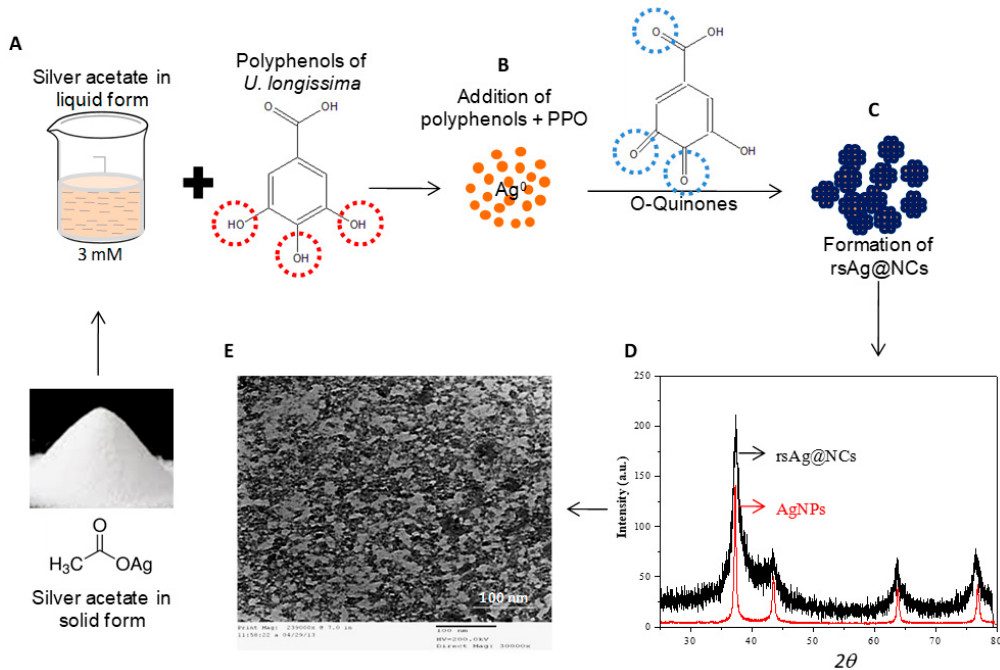
Figure 1. Approach to for fabricating bionanoclusters of silver (rsAg@NCs) using phytochemicals of Usnea longissima . ( A ) A solution of silver acetate (3 mM) was challenged with aqueous extract of U. longissima (AEU; 2 mg/mL) in reaction glassware. ( B ), Polyphenols of AEU reduce Ag + into Ag°, and form o -quinones, due to bioconversion of polyphenols by the action of polyphenol oxidase (PPO; 5 units/mL). Quinones contain an oxygen group (neutral charge), and an accumulation of quinones on the surface of AgNPs helps to form ( C ), clusters of AgNPs (denoted as “rsAg@NCs) due to the absence of electronic hindrances between the nanoparticle (NPs). ( D ) x-ray diffraction (XRD) pattern of the rsAg@NCs and AgNPs were recorded in the range of 20° to 80° at a 2 θ angle. XRD pattern of the rsAg@NCs depicts the well-resolved diffraction peaks broadening of the crystalline zerovalent silver (Ag°) NCs as compared to the AgNPs, which can be assigned to the reflection planes: 111, 200, 220, and 311. ( E ) Transmission electron microscopy(TEM) image reveals the shape, size, and clustering nature of the NCs. Red circles show the hydroxyl groups of the polyphenols, which are responsible for reducing the potential by donating hydrogen to Ag + and forming Ag°. Blue circles are indicating neutral charge-free oxygen molecules ( O -quinones) by the action of polyphenol oxidase (PPO) that promote the formation of NCs of AgNPs.